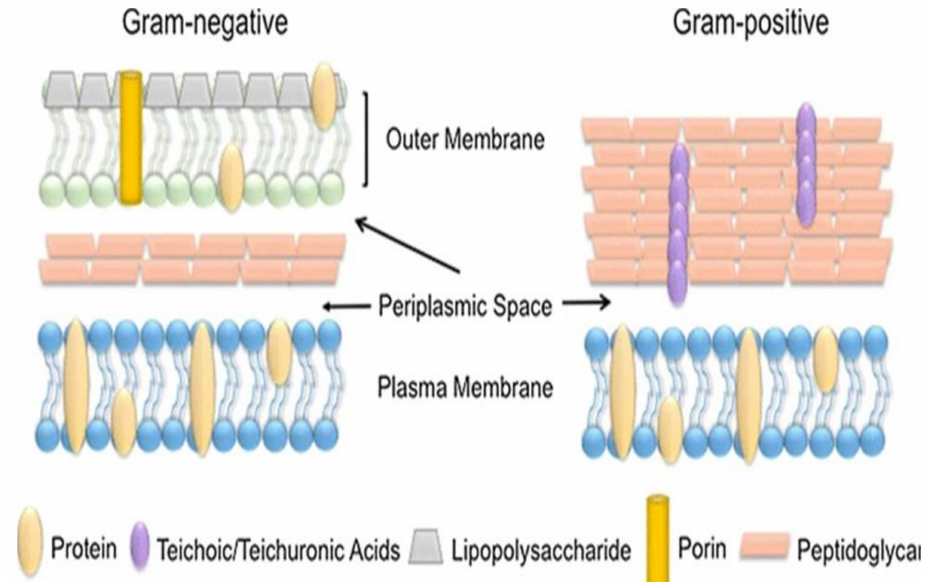
Figure 4. Schematic differentiation of the gram-negative and positive cells